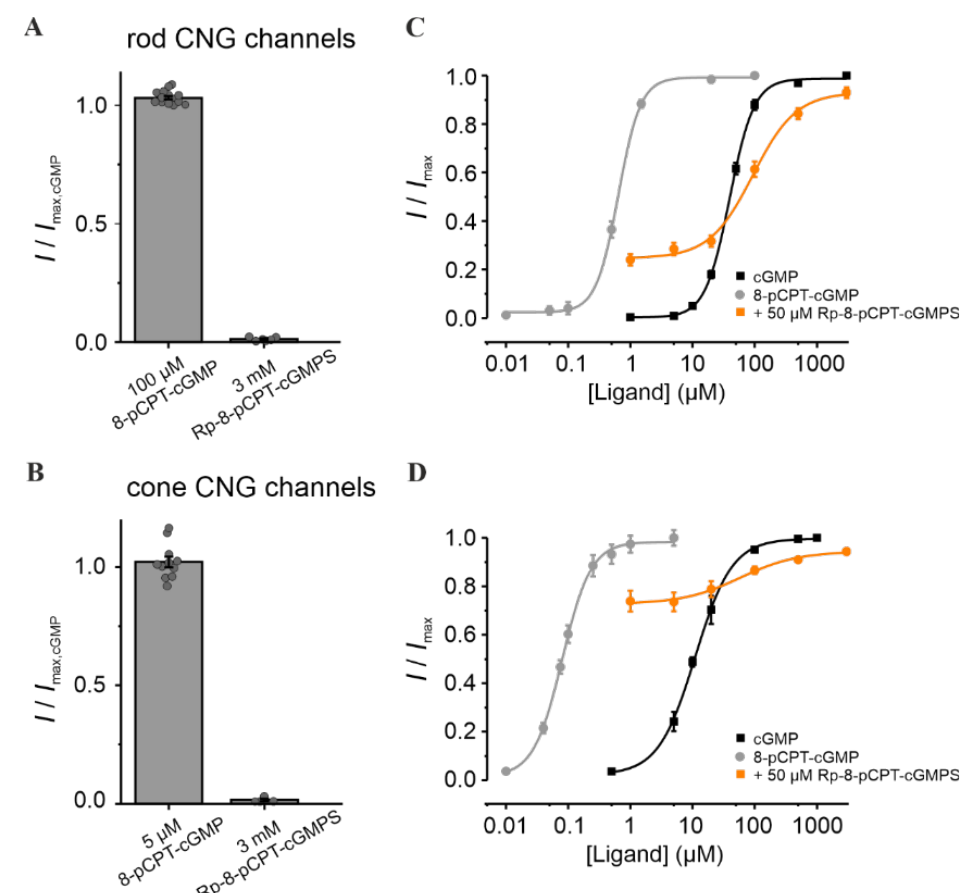
Figure 3. Effect of Rp-8-pCPT-cGMPS and 8-pCPT-cGMP on retinal CNG channels. ( A , B ) Efficacy of Rp-8-Br-pCPT-cGMPS and 8-pCPT-cGMP when activating rod and cone CNG channels. The CNG-channel currents triggered by the respective cGMP analogues were related to the maximal cGMP-induced current measured at +100 mV (3 mM and 1 mM cGMP for rod and cone channels, respectively; n = 4 – 16). The gray symbols represent individual measurements. ( C , D ) Concentration – activation relationships for rod and cone CNG channels obtained in the presence of cGMP (black), 8-pCPT-cGMP (gray) and cGMP + Rp-8-pCPT-cGMPS (50 µM, orange). The experimental data points, representing means of several measurements were fitted with Equation (1) (for EC 50 , H and